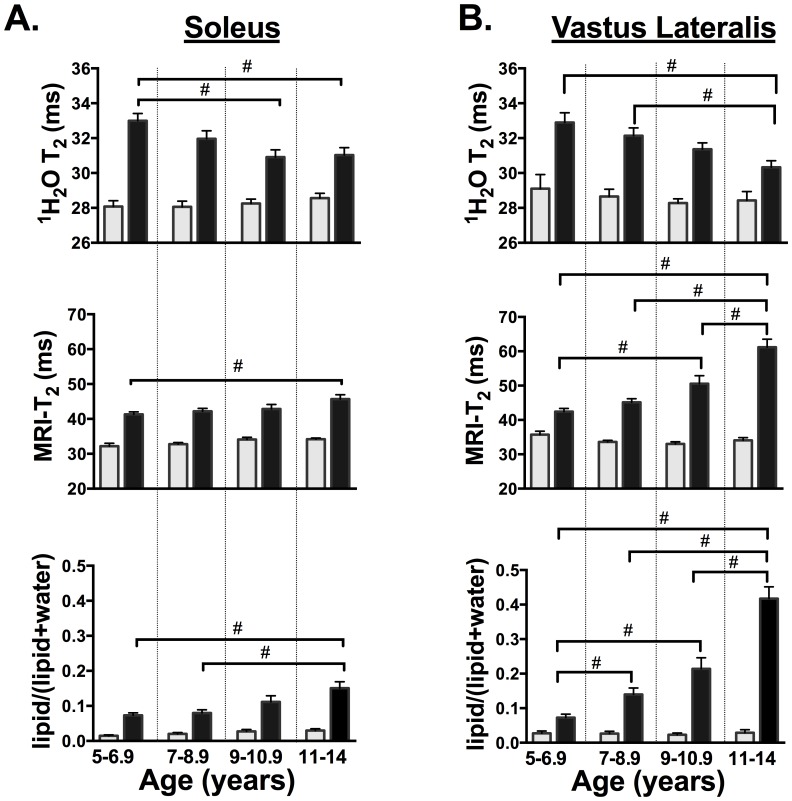
MRS 1H2O T2 (ms), MRI-T2 (ms), and lipid fraction [lipid/(lipid+water)] in the soleus (A) and vastus lateralis (B) of control and DMD age groups.DMD were significantly different (<0.05) than controls in all age groups, except lipid/(lipid+water) of the vastus lateralis in the 5–6.9 age group. # denotes significantly different (<0.05) between age groups in DMD. No differences were observed among age groups in controls. Bars represent mean (SEM).